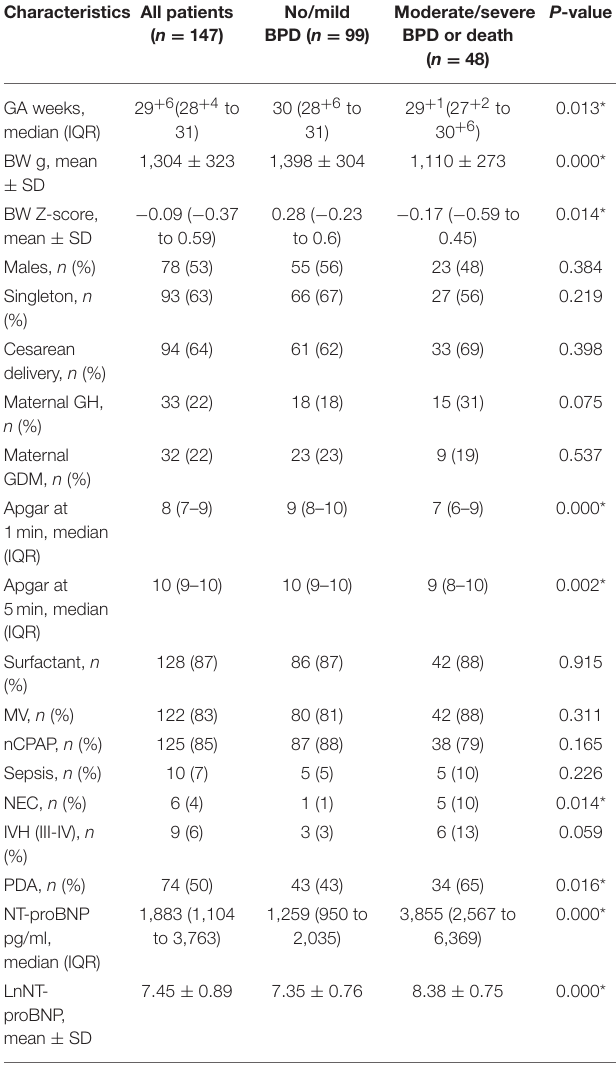
TABLE 1 | Clinical characteristics of the groups with and without BPD. Characteristics All patients ( n =